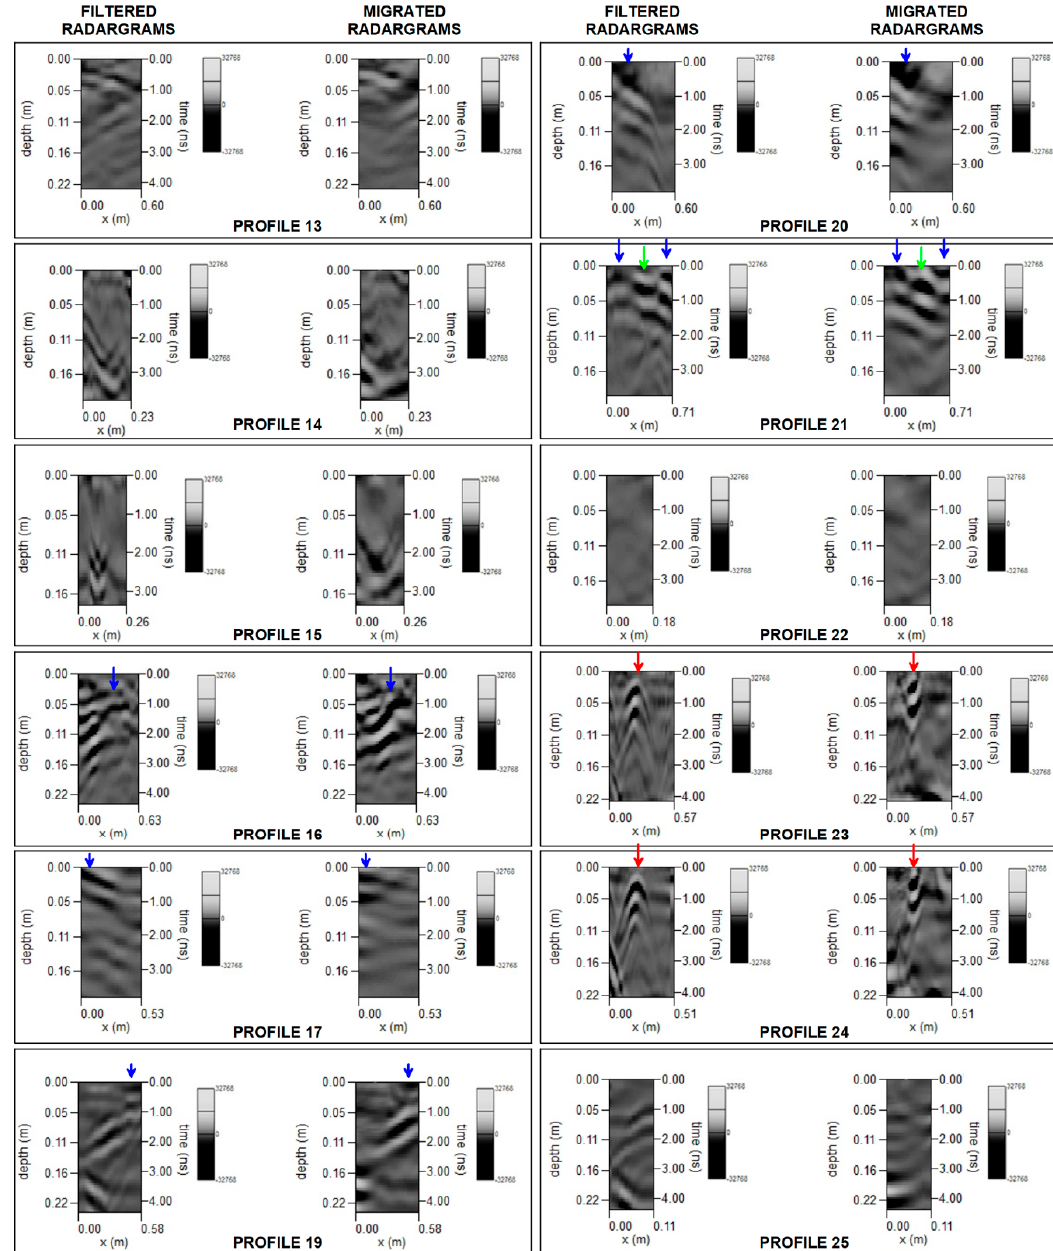
Figure 10. Filtered and migrated radargrams of profiles 13–17 and 19–25.